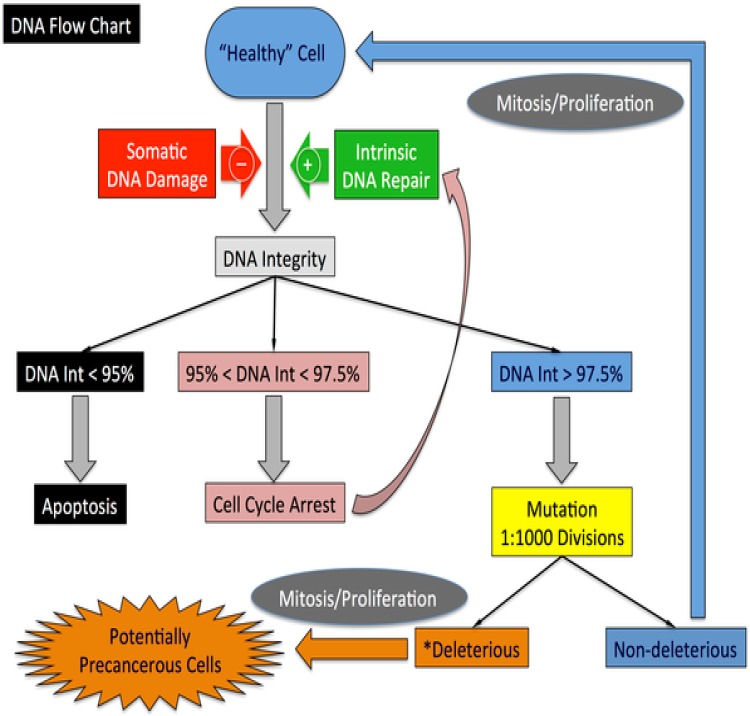
Overview of mechanisms governing DNA damage and repair and mutation in the Duct Epithelium Agent-based Model (DEABM).Cells acquire and repair a random but limited amount of DNA damage every day. Cells dividing with DNA damage can acquire mutations. Excessive amounts of DNA damage lead to either cellular senescence or apoptosis. If damage occurs to one of the copies of the specifically labeled “functional genes” there is no functional effect. If both copies of a gene is mutated the respective functions associated with that genes are modified, leading to altered cellular behaviors. Figure reproduced from[18] under the Creative Commons Attribution license.